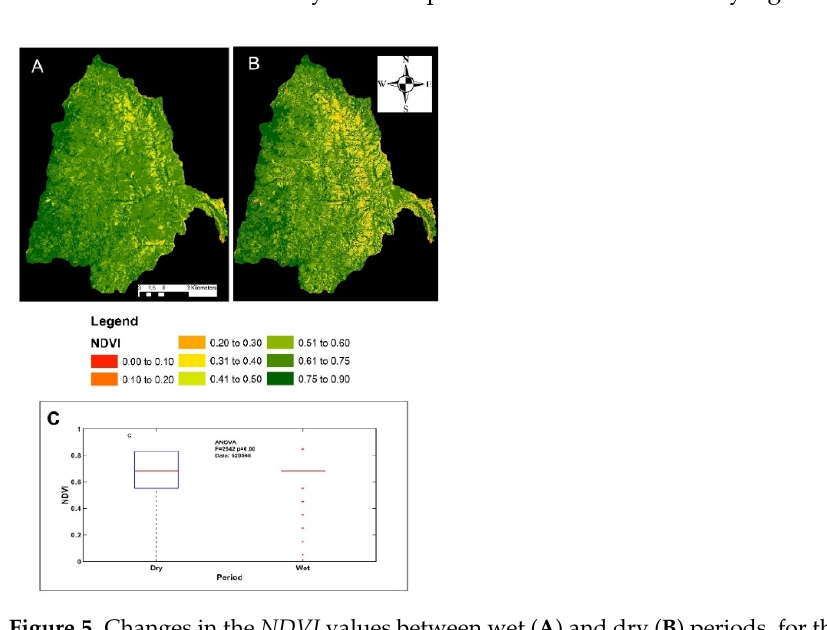
Figure 4. Rainfall erosivity factor, R . Color codes indicate normal, el Niño and la Niña years.